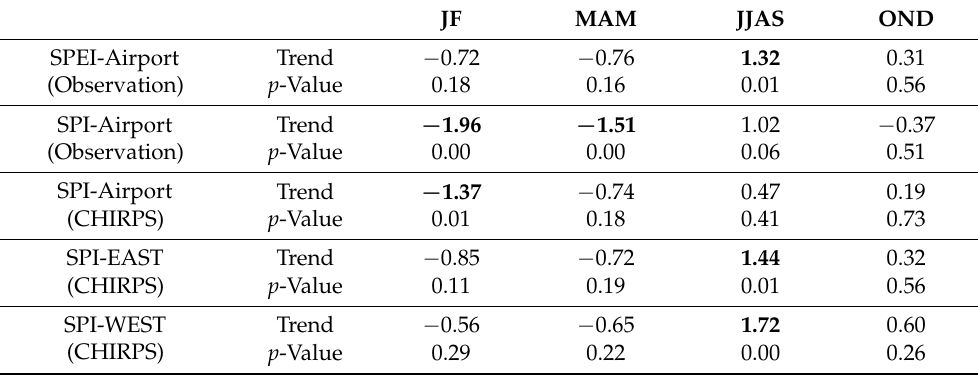
Table 5. Seasonal trends of the SPI and SPEI at Djibouti Airport station (observed and CHIRPS data) and in the two subregions over the 1981–2021